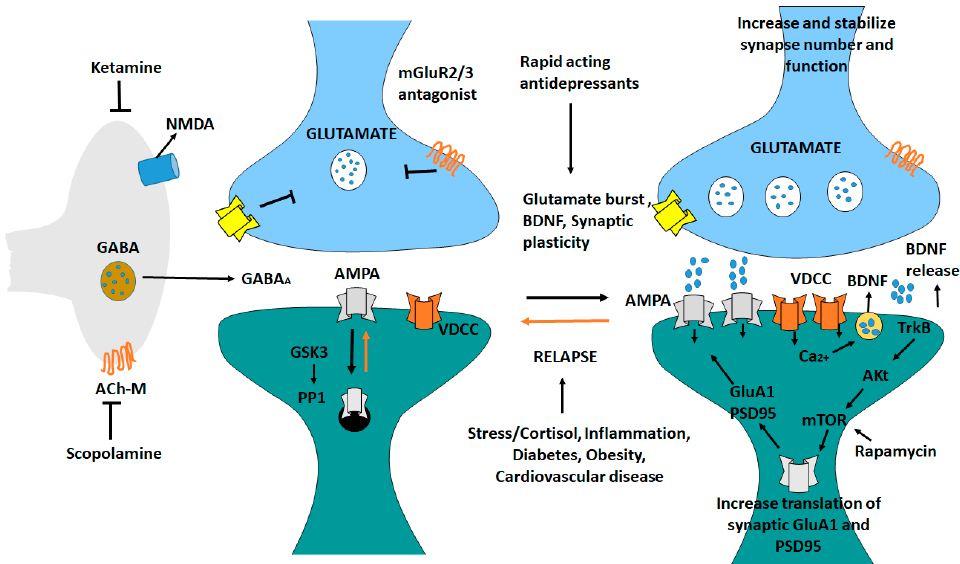
Figure 7. Antidepressant ketamine pathway. Ketamine causes a burst of glutamate which stimulates AMPA receptors causing depolarization and activation of voltage dependent Ca 2 + channels, leading to release of BDNF and stimulation of TrkB-Akt that activates mTORC1 signaling leading to increased synthesis of proteins required for synapse maturation and formation. In other conditions where BDNF release is blocked the synaptic actions of ketamine are blocked. Scopolamine also causes a glutamate burst via blockade of acetylcholine muscarinic M1 (ACh-M1) receptors on GABA interneurons [239].